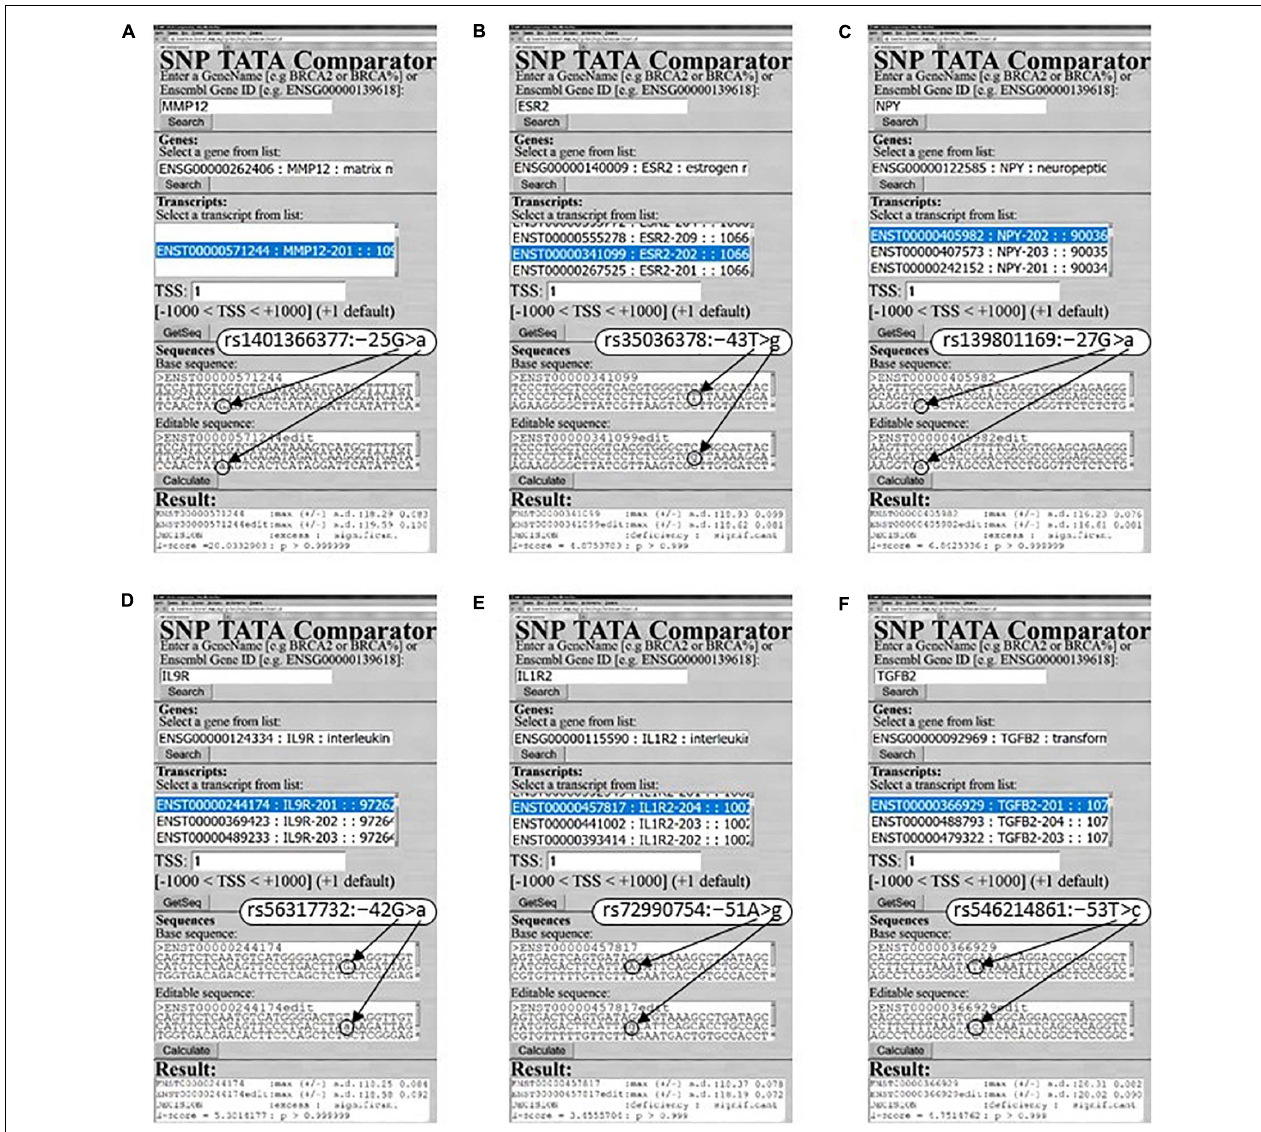
FIGURE 3 | Examples of our predictions for human RA-related genes in this work. (A) MMP12 : rs1401366377; (B) ESR2 : rs35036378; (C) NPY : rs139801169; (D) IL9R : rs56317732; (E) IL1R2 : rs72990754; (F) TGFB2 :